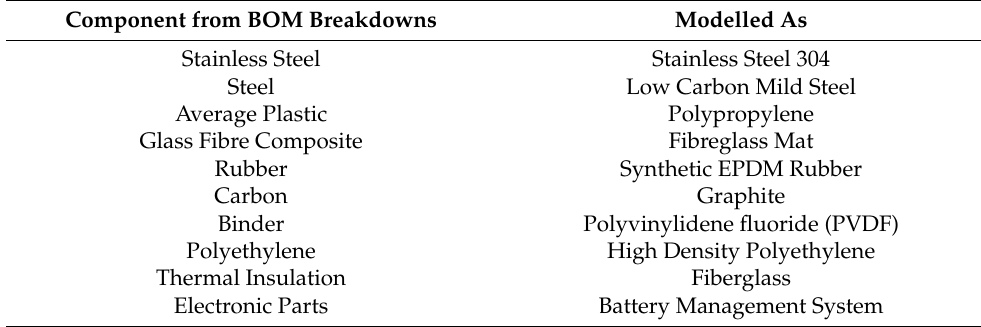
Table 6. Component